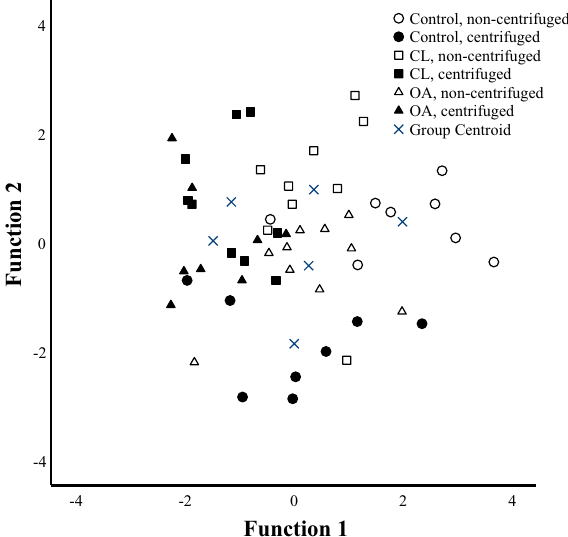
Figure 5. Discriminant analysis depicting the classification of confocal laser scanning microscopy data in equine synovial fluids. The samples were collected from control, contralateral (CL), and osteoarthritic (OA) fetlock joints, and the data classified based on discriminant functions 1 (on x-axis) and 2 (y-axis) that together explain 57.5% of the variance in the dataset. The samples were analyzed unprocessed and centrifuged at 1000 × g for 10 min prior to